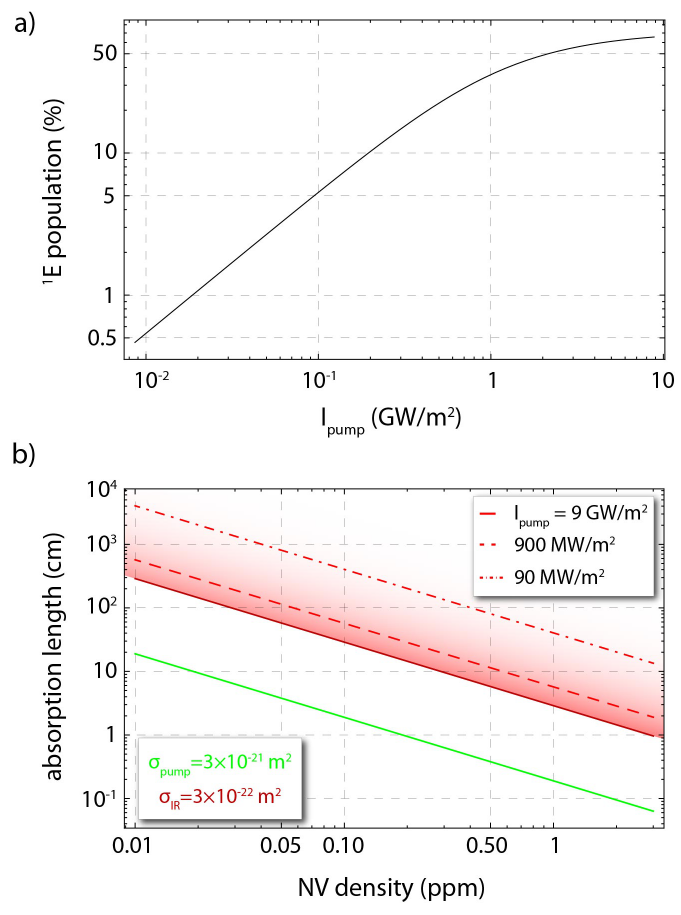
Figure 2. ( a ) Estimated population in the singlet 1 E state as a function of the pump (532nm) intensity. ( b ) Absorption lengths as a function of the NV-density, for the pump radiation (green solid, line), and for the IR (1042nm) probe radiation (red solid, dashed, and dotted, lines) for three different pump intensities (which yield different populations in the 1 E state). Simulations are based on a rate-equation model for the NV center following the works in